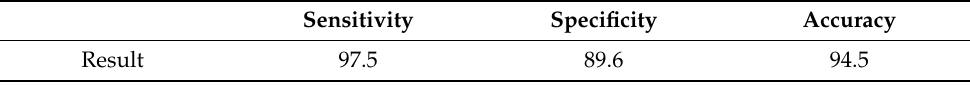
Table 3. The experimental calculation results on the NTU dataset (six types of actions)